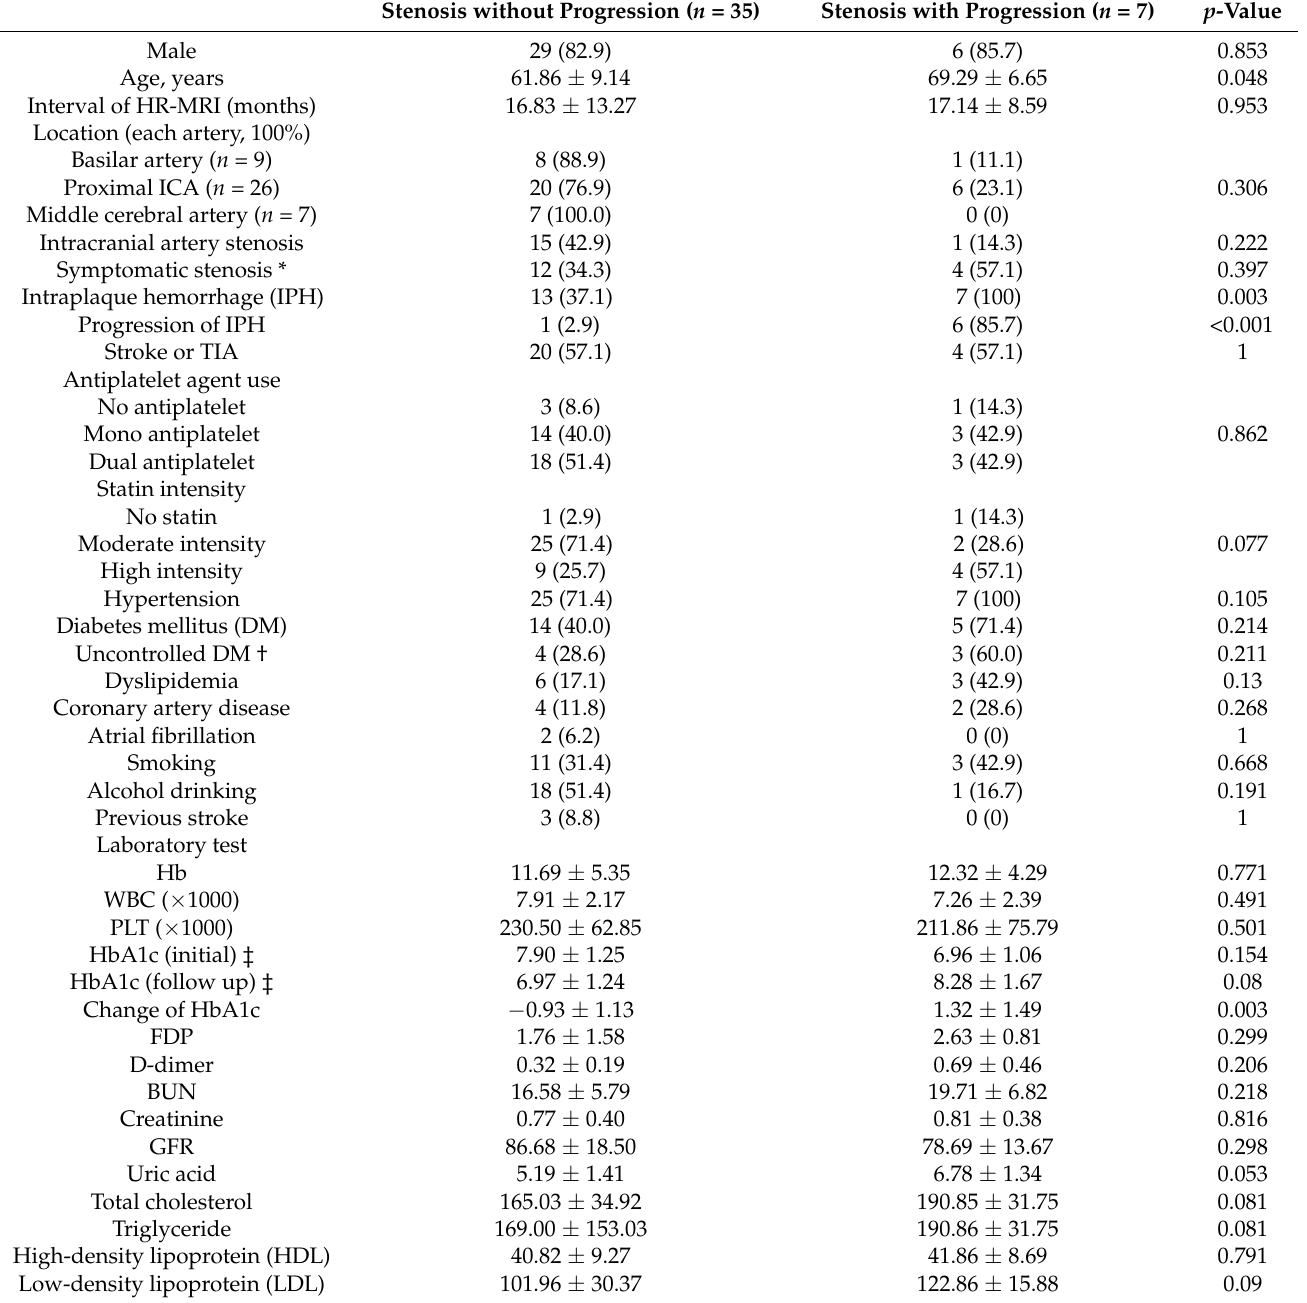
Table 3. Comparison of the demographics of patients according to progression in cerebral artery stenosis. Stenosis without Progression ( n = 35) Stenosis with Progression ( n = 7) p -Value Male 29